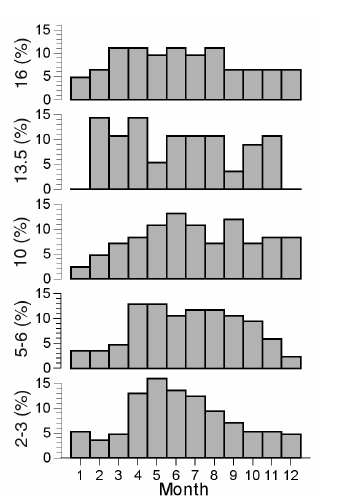
Fig. 10.3. Percentage of occurrence of PWS events ( y axes) as function of month during the time interval 1983- 2001 (adapted from Altadill and Apostolov, 2003).